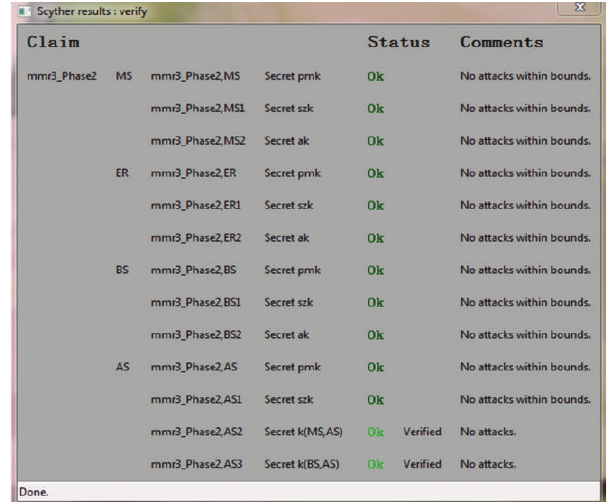
Figure 10: Verification result for Protocol 3-Phase 3, distributed